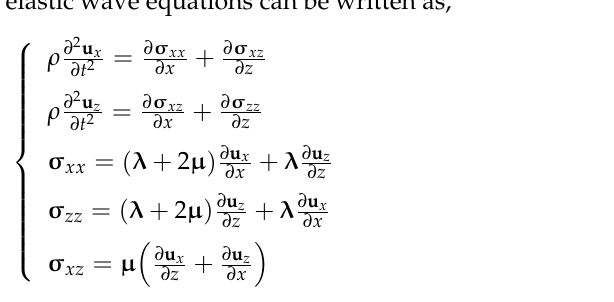
Figure 3. Seismic waveforms. ( a ) Measured and synthetic data; ( b ) phase-corrected measured and synthetic data.